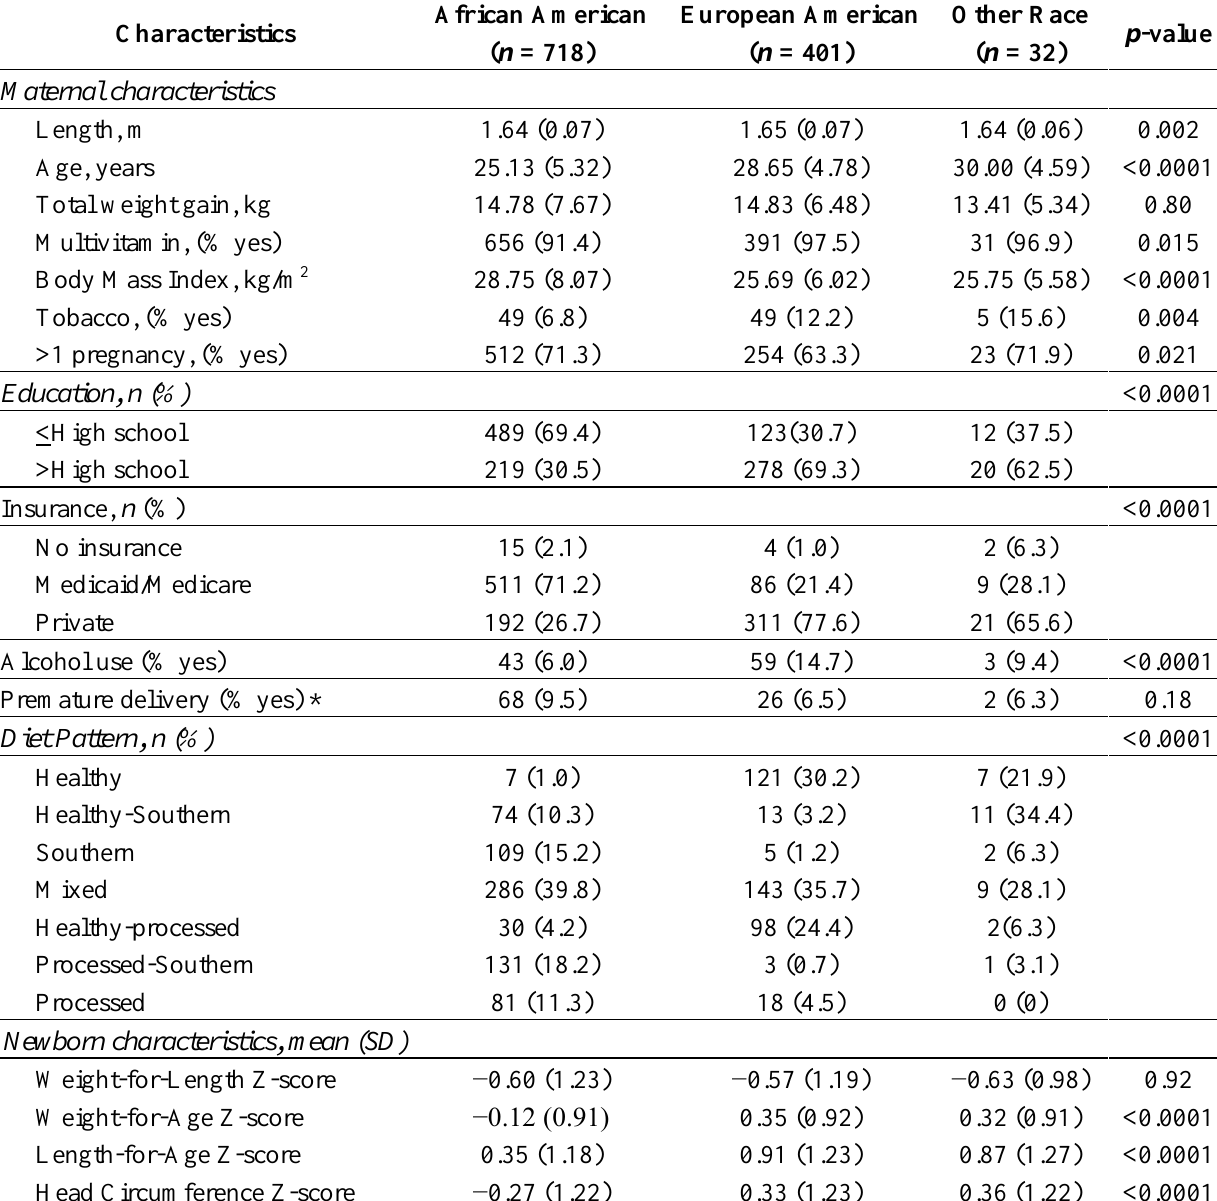
Table 2. Population characteristics of mothers and newborns of the CANDLE study ( n = 1151). Values are number (%) or means (standard